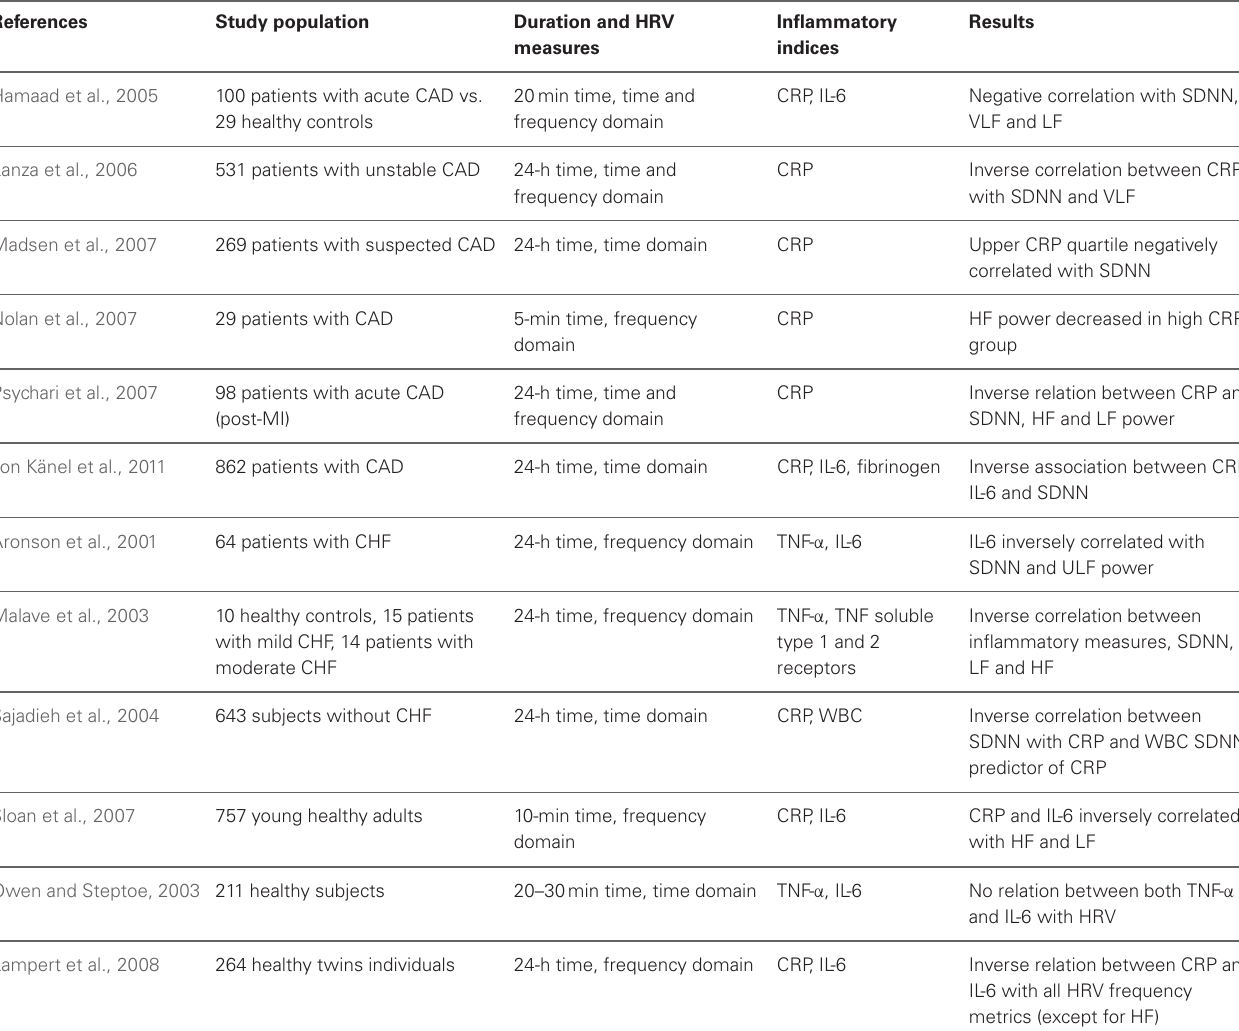
Table 3 | Summary of several clinical studies investigating a possible association between HRV indices and inflammation in patients with CAD, CHF and healthy